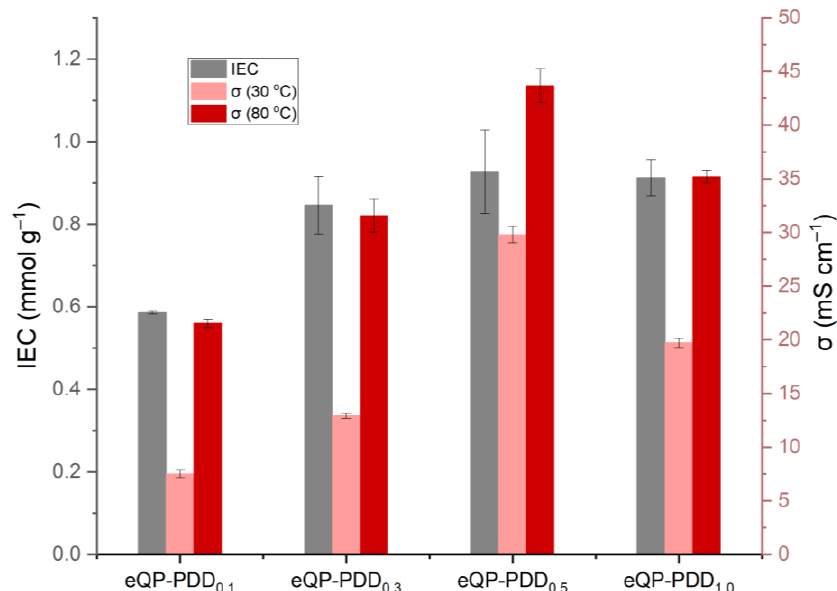
Figure 10. Ion exchange capacity and hydroxide conductivity of eQP-PDD x AEMs. Table 4. Reported IEC and OH − conductivity for PVA-based AEMs at 60–80 ◦